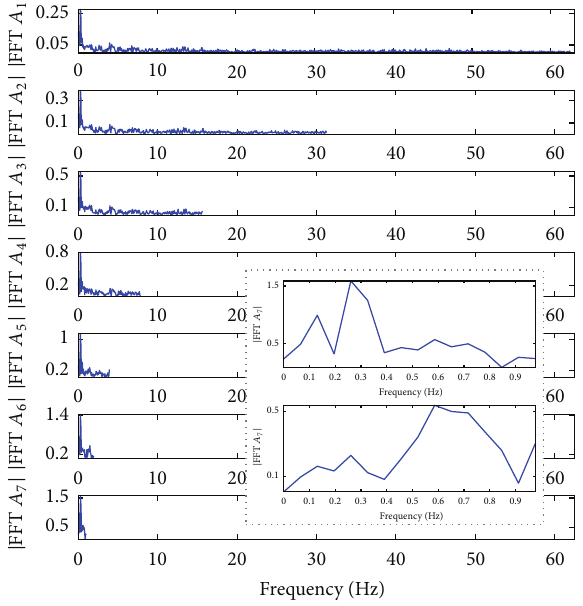
Figure 3: FFT of ECG DaIsy dataset lead 4 ECG1 and FFTs of approximation sequences, at decomposition levels from 1 to 7 and zoom to FFTs approximation and detail level